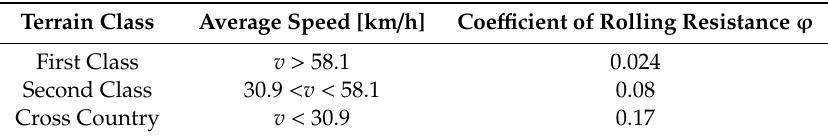
Table 3. Terrain